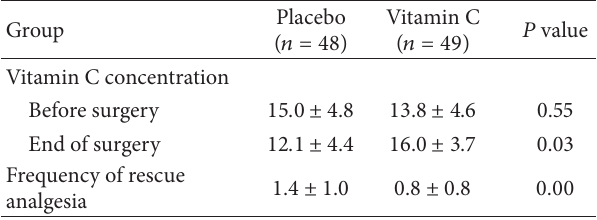
Table 2: Plasma vitamin C concentrations ( 𝜇 mol/L) and frequency of postoperative rescue